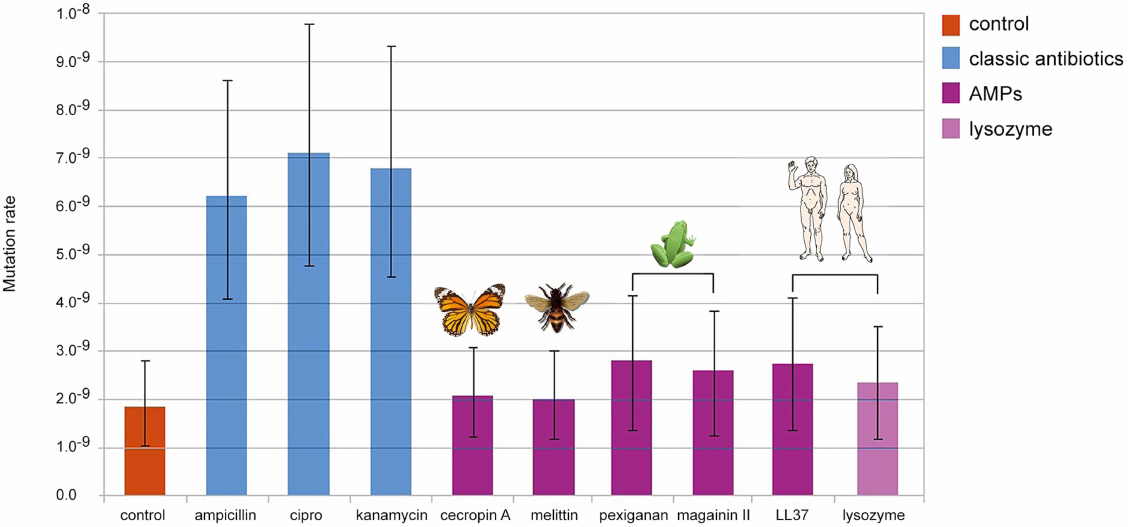
Figure 1. Changes in mutation rate in E. coli MG1655 induced by different antimicrobial treatments. Error bars show confidence interval for mutation rate estimation by plating in Rifampicin (100 m g/ml) and using the maximum likelihood method. Each bar represents the mutation rate from 10 independent cultures. All cultures were treated for 4 hours, with their corresponding MIC50 values for each antimicrobial as follow: 3.2 m g/ml of ampicillin, 0.05 m g/ml of ciprofloxacine, 1.6 m g/ml of kanamycin, 6 m g/ml of cecropin A, 12.8 m g/ml of human lysozyme, 8 m g/ml of LL-37, 1.6 m g/ ml of melittin, 64 m g/ml of magainin II and 1.6 m g of pexiganan.